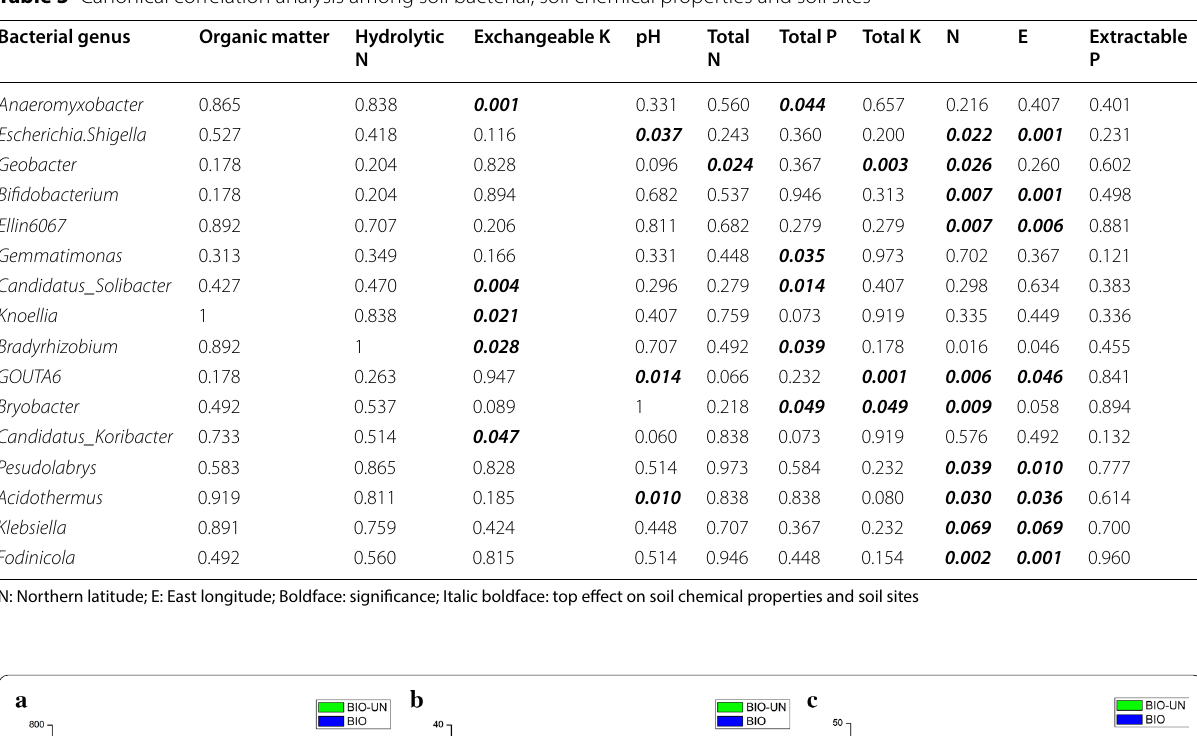
Table 3 Canonical correlation analysis among soil bacterial, soil chemical properties and soil sites Bacterial genus